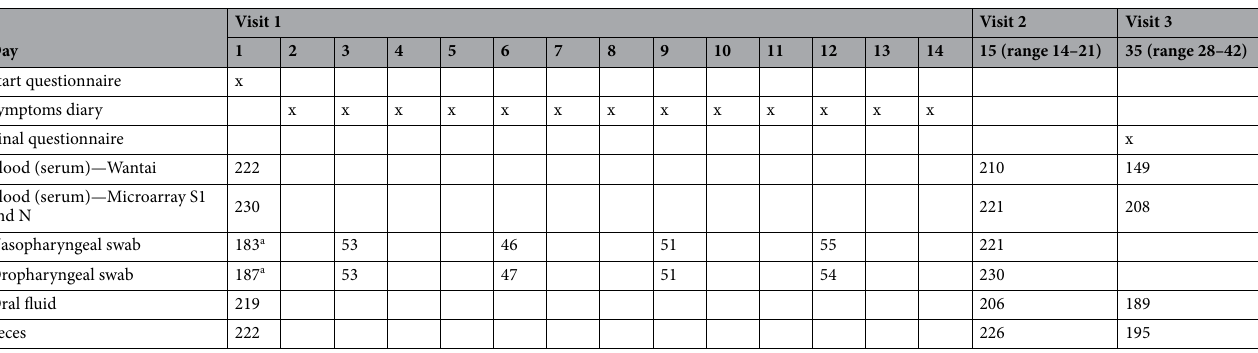
Table 1. Schedule of administering questionnaires, symptom diaries and home visits for sampling. The numbers in the table indicate the amount of analysed specimens in 242 participants. a A naso- and oropharyngeal swab was not collected for the index case at the first home visit, as these persons were already swabbed a few days before and tested SARS-CoV-2